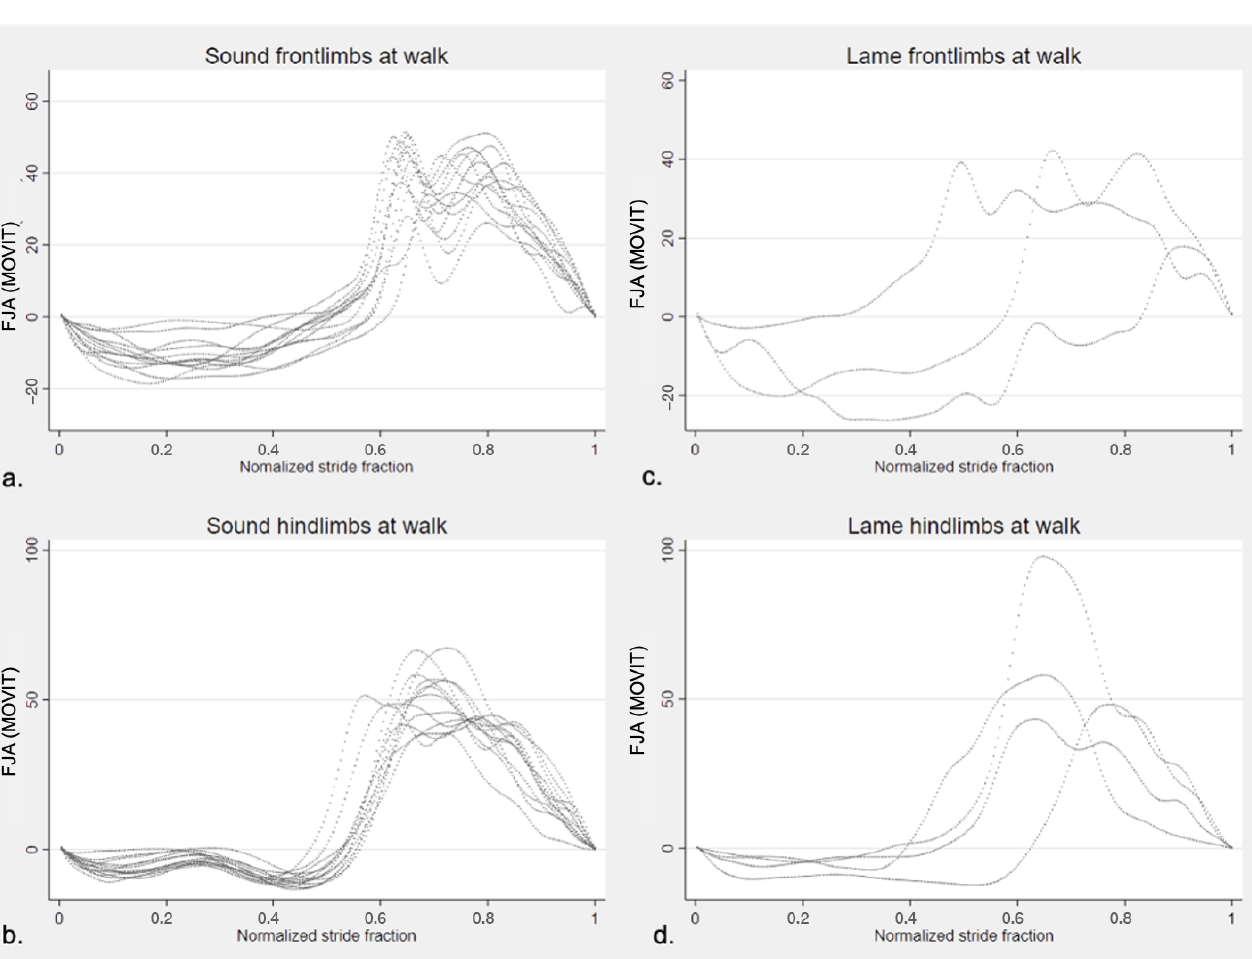
Figure 6. Fetlock joint angle pattern of one normalized entire stride of the horses in the study quantified by MOVIT IMU system at walk. Positive values of angles (°) represent flexion and negative values extension of the fetlock joint. ( a ) left and right sound forelimbs ( n = 14); ( b ) left and right sound hindlimbs ( n = 14); ( c ) lame forelimbs ( n = 3); ( d ) lame hindlimbs ( n = 4).